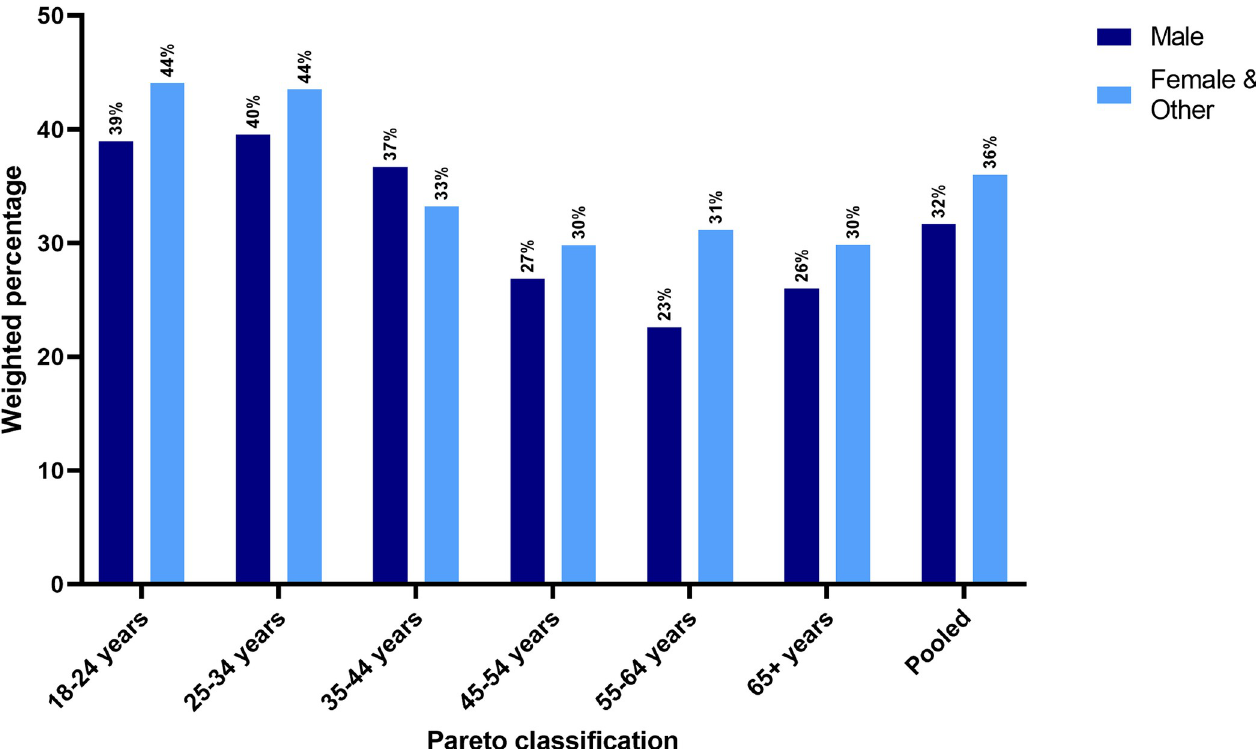
Fig 2. Percentage of each age group reporting “Worsened” anxiety/depression, by gender. Note: Because of small numbers, the respondents who reported their gender as “Other” were arbitrarily combined with those who identified as “Female” for the purposes of the analysis.